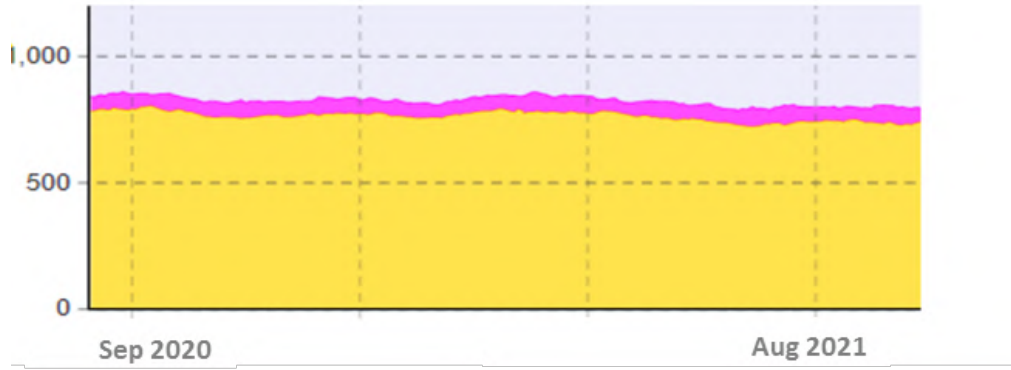
Figure 9: Future level of motivation of